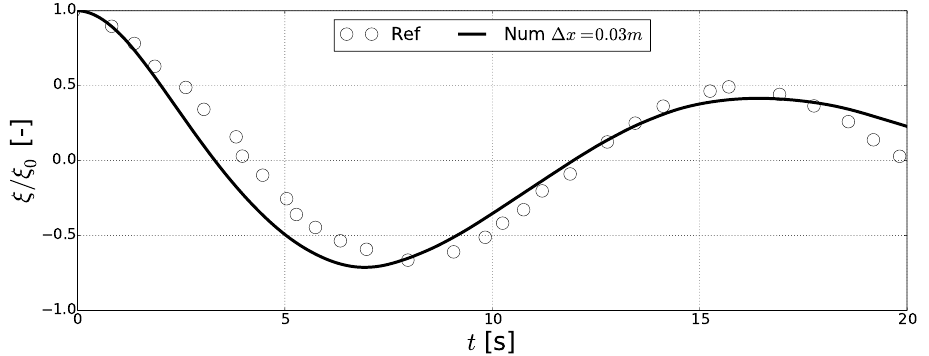
Figure 16. Convergence of the numerical solution for the free surge decay test for the support structure. The numerical reference solution was taken from [54].